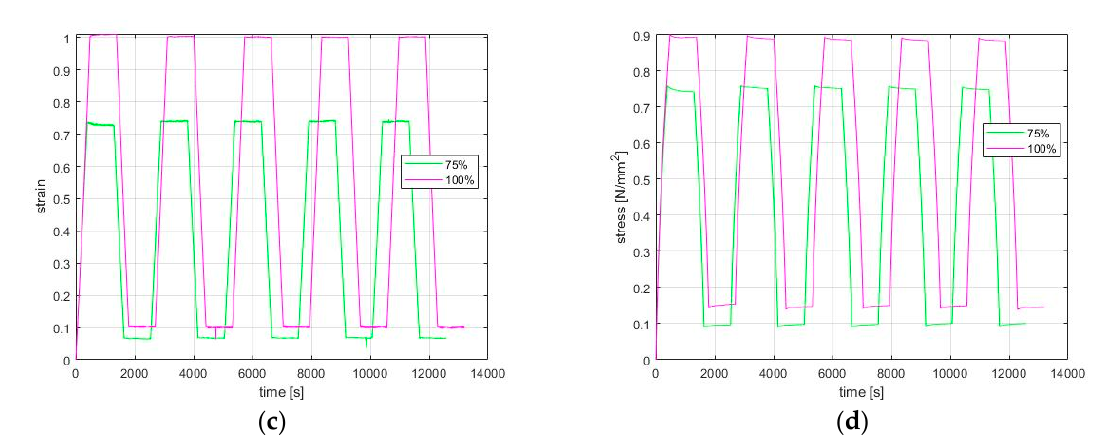
Figure 3. Five repeating cycles of loading–unloading with relaxation and its recovery for different strain levels. Graphs in the left column show the history of applying ( a ) 25%, 50%, ( c ) 75%, and 100% and partially removing the strain until it reaches 10% of the applied strain over time (cause). Graphs on the right column show the stress response following the application and removal of ( b ) 25%, 50%, ( d ) 75%, and 100% as a step function of time (effect).